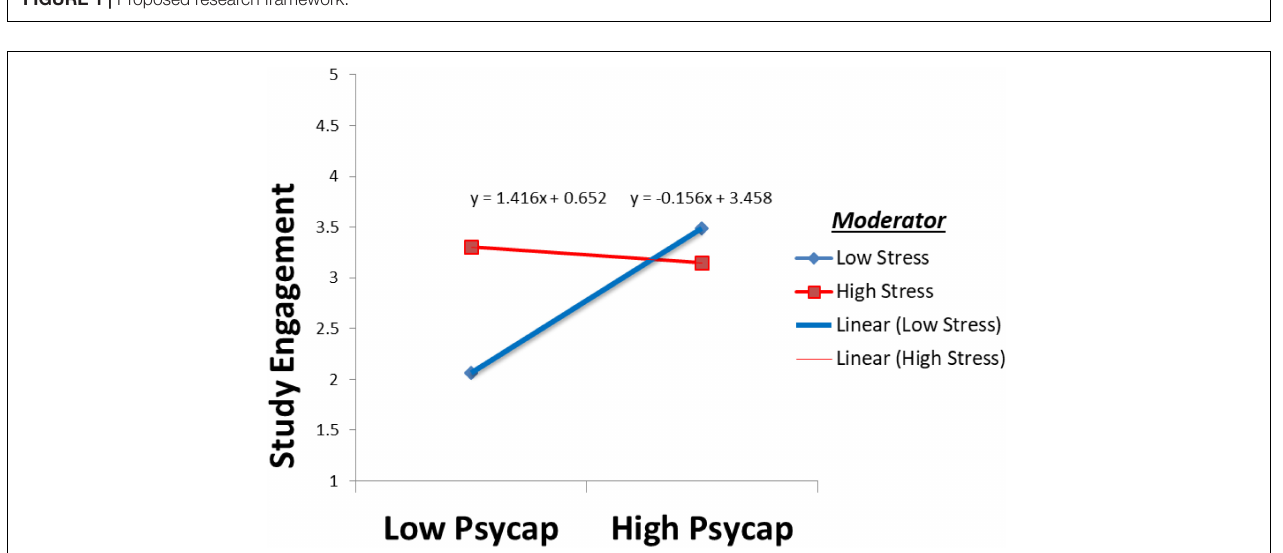
FIGURE 2 | Moderation/interaction effect of stress between psychological capital (PsyCap) and study